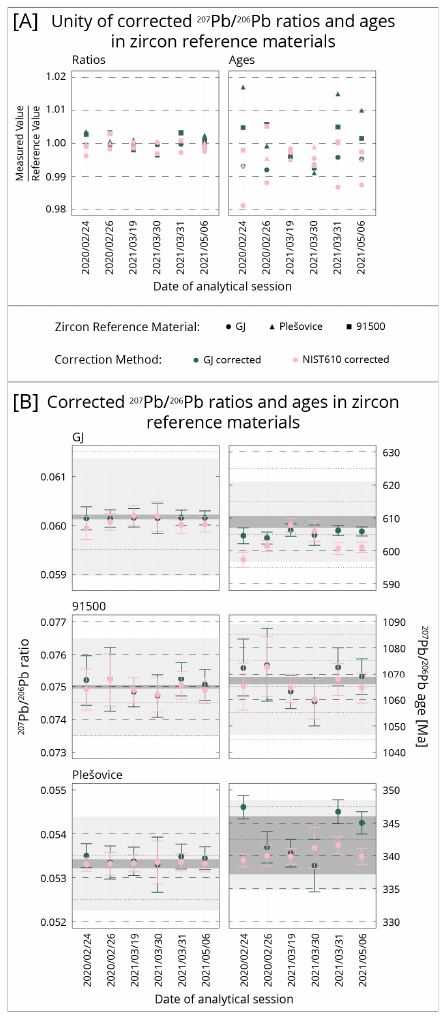
Figure A1. ( A ) Unity measure (observed/reference value) of corrected Pb isotope ratios and ages. ( B ) individual observed corrected ratios and ages for each natural zircon reference material used. Dark grey shading is the reference value range (2 × standard error), light grey shading is the 2% unity range (reference value ± 2%). Uncertainties on observations are 2 standard error. Refence values are from